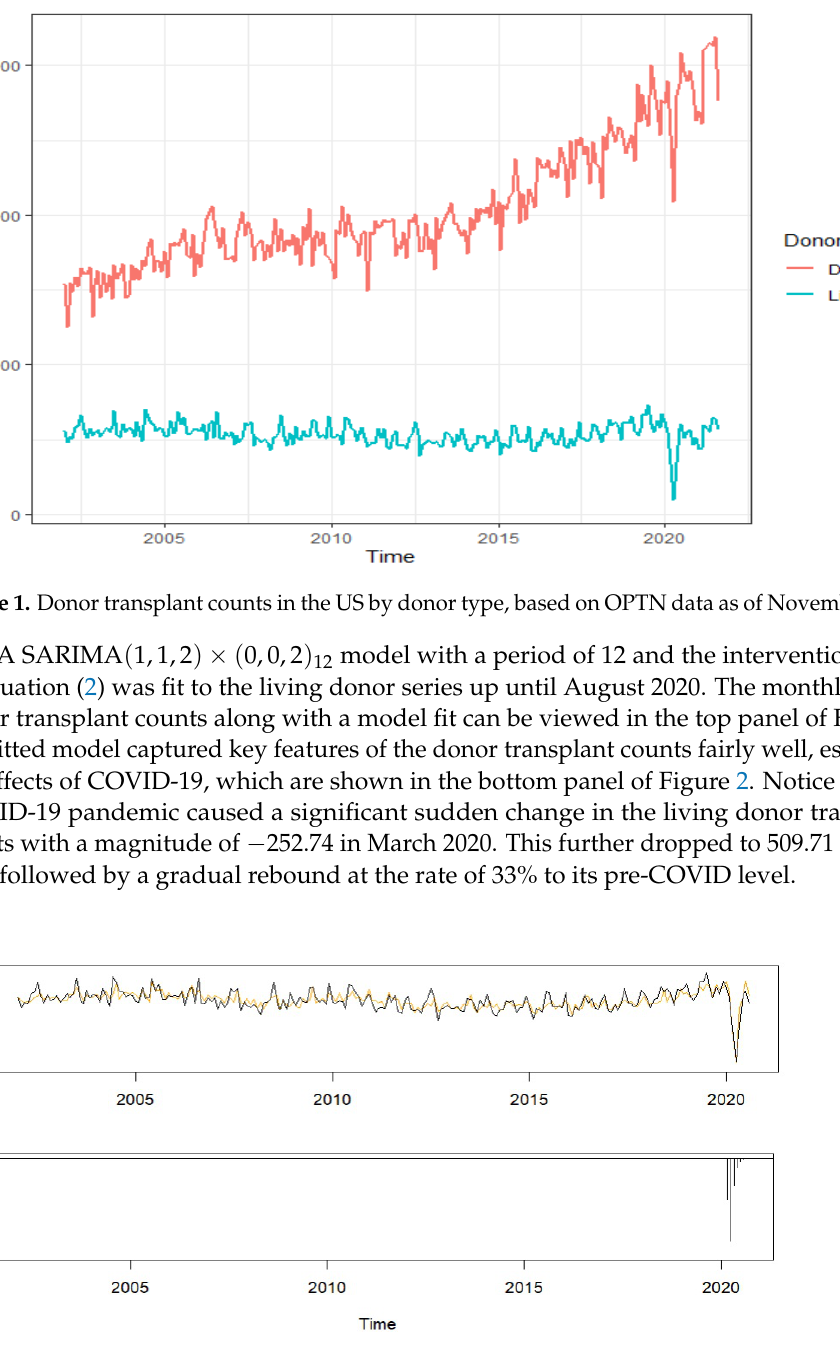
Figure 2. Living donor transplant counts with the model fit ( top ) and the estimated COVID-19 effects ( bottom